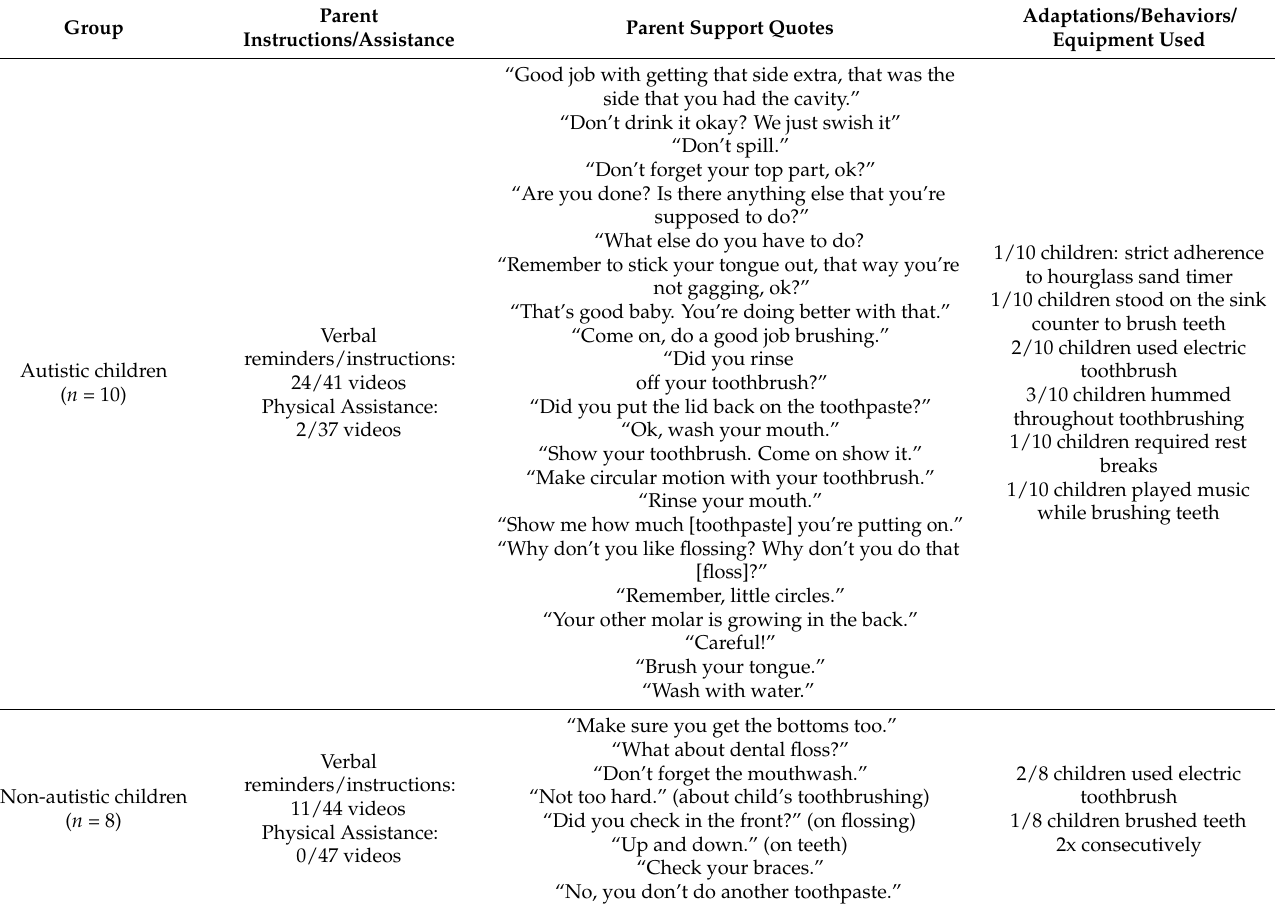
Table 4. Summary of observed oral care